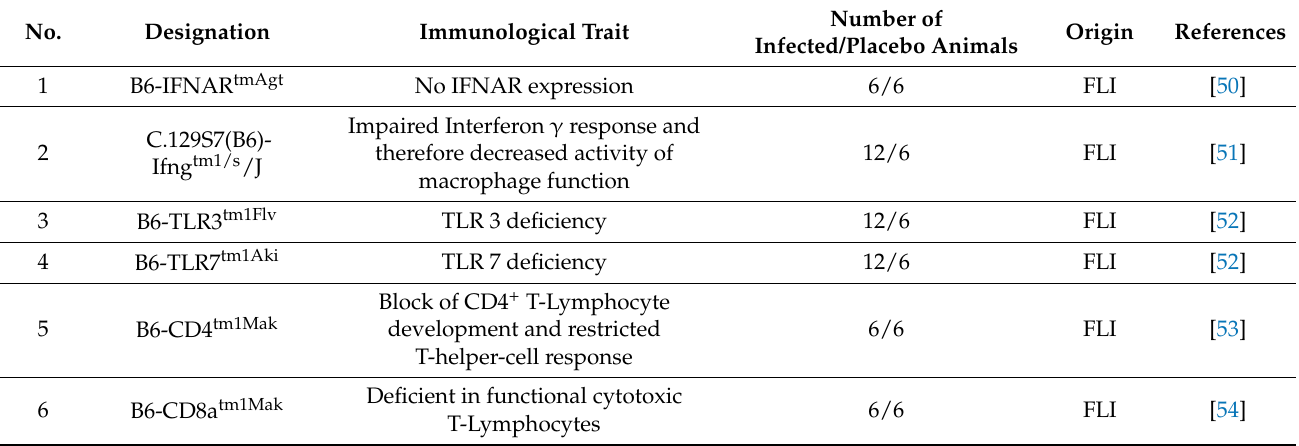
Table 1. Various mouse strains used for the present investigation and their relevant